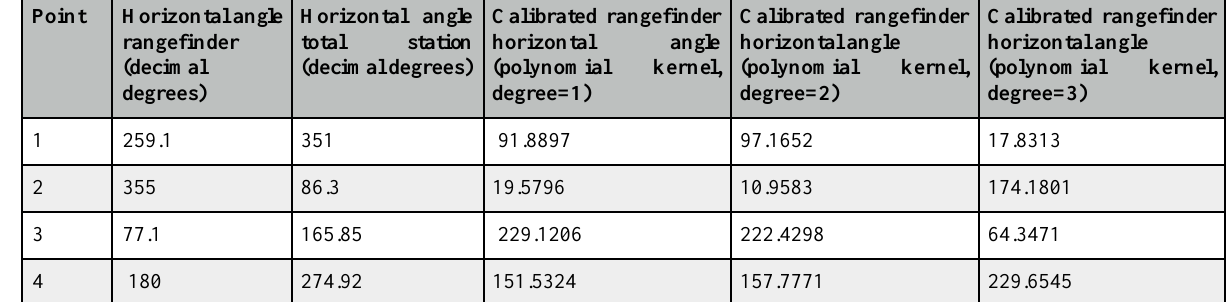
Table 5: Calibration of room 10 rangefinder horizontal angle measurements using total station horizontal angle measurements by polynomial kernel calculated from room 1. Point Horizontal